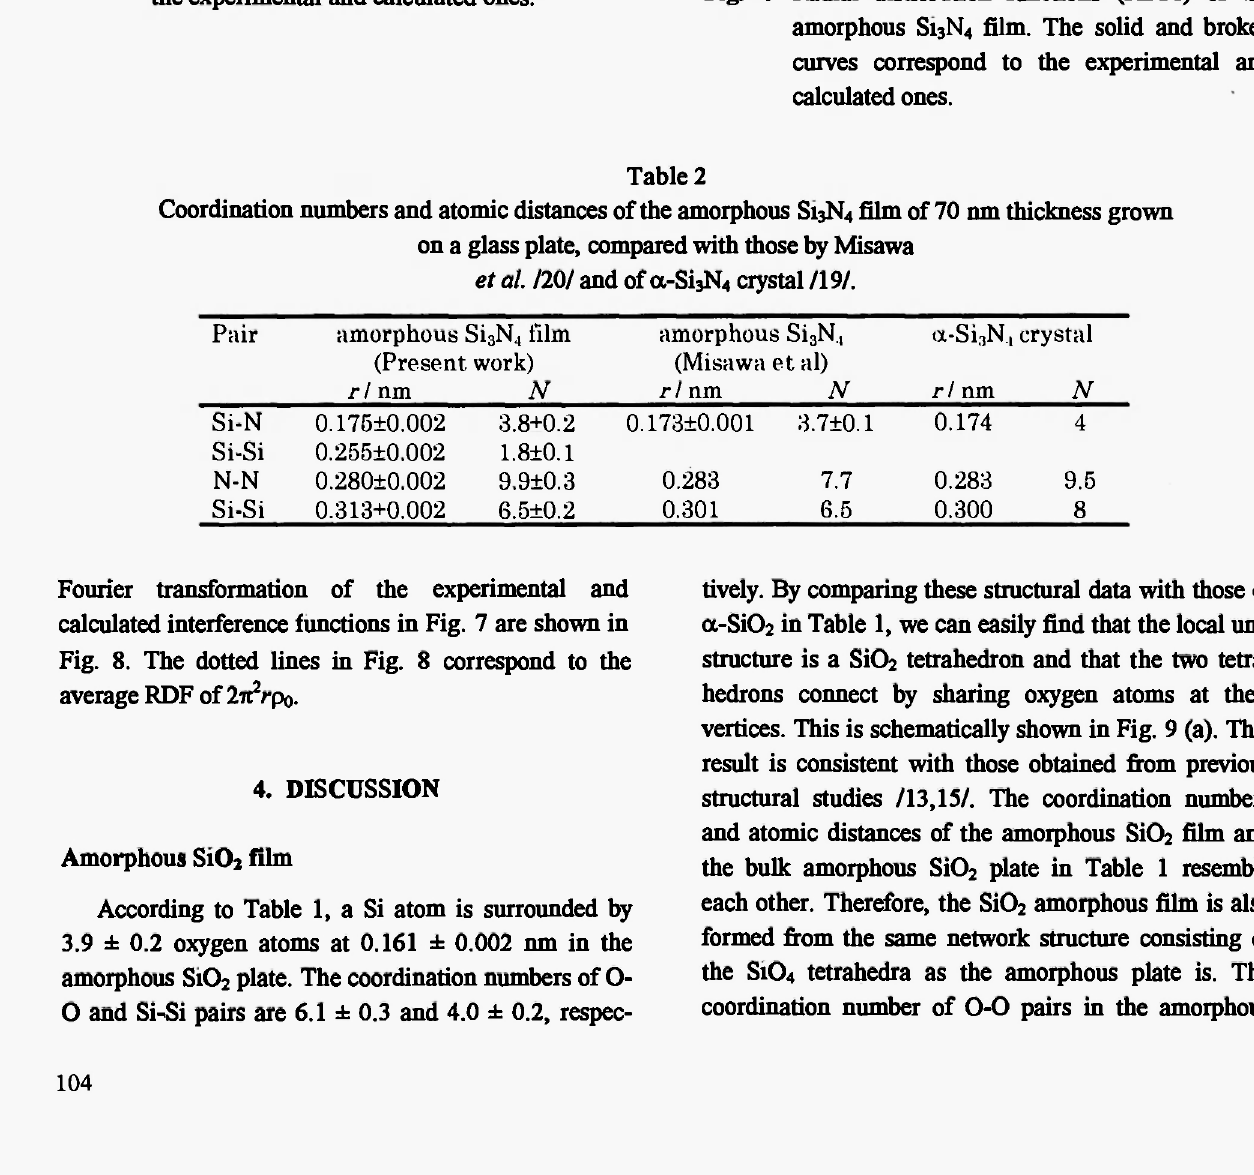
Fig. 7: Interference functions in the amorphous S13N4 film. The solid and dotted curves correspond to the experimental and calculated ones. Fig. 8: Radial distribution functions (RDFs) of the